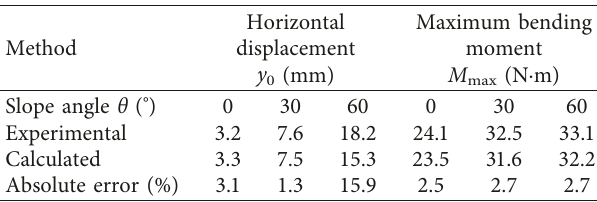
Figure 8: Pile behavior under the horizontal load, Q 0 (cid:31) 50N: (a) horizontal displacement; (b) rotation; (c) bending moment; (d) shear Table 1: Comparison of pile behavior between the proposed method and the model tests.